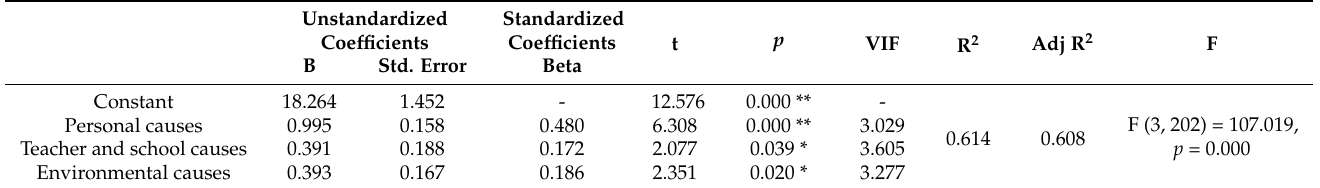
Table 3. Parameter Estimates linear regression of the relationship between the three factors and academic